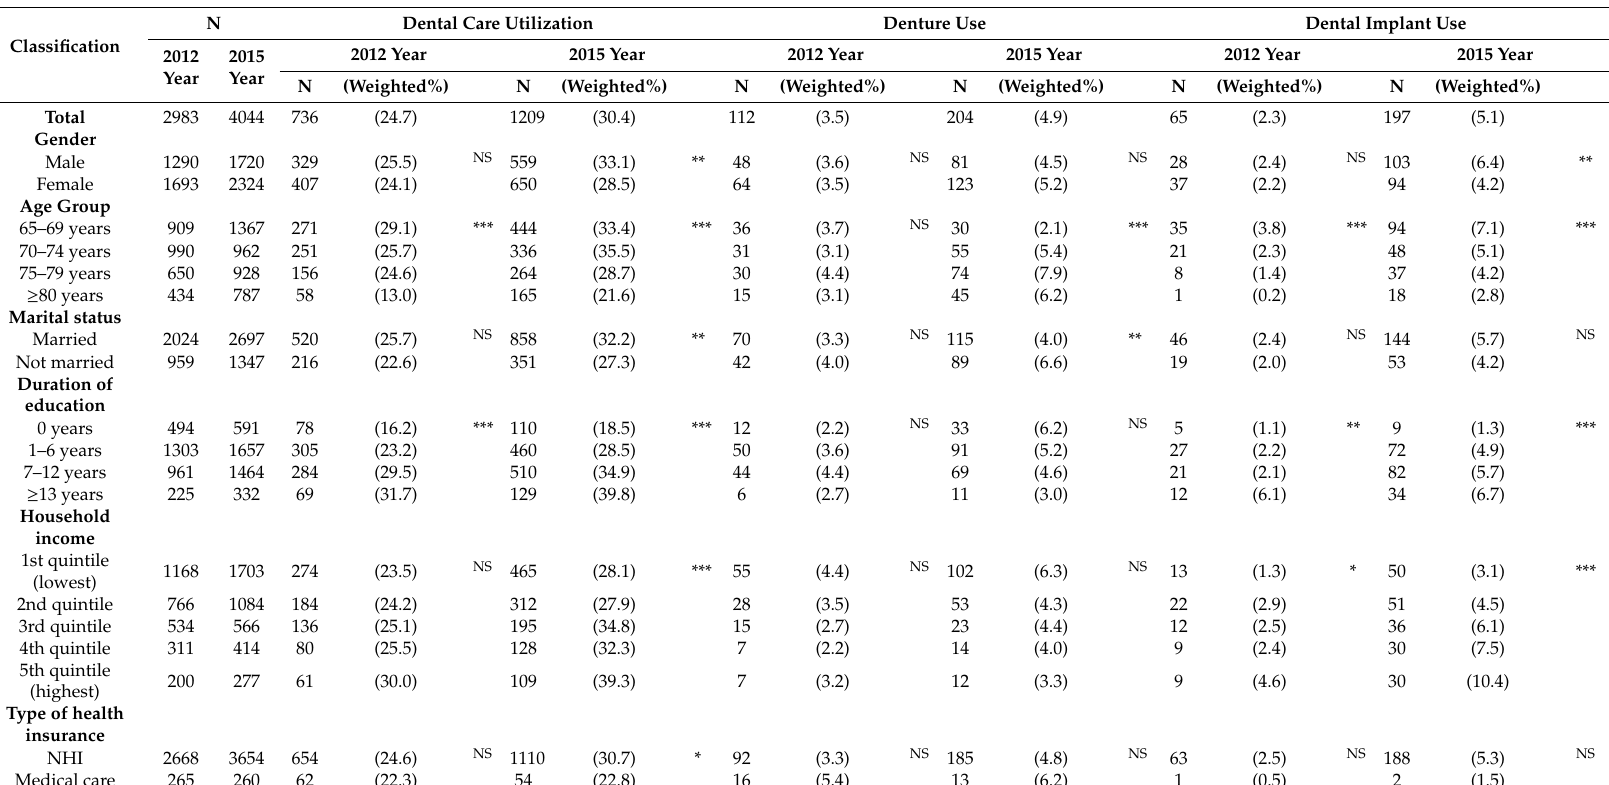
Table 1. Changes in the annual dental care utilization according to sociodemographic characteristics after expanded coverage of dental prostheses for older adults.